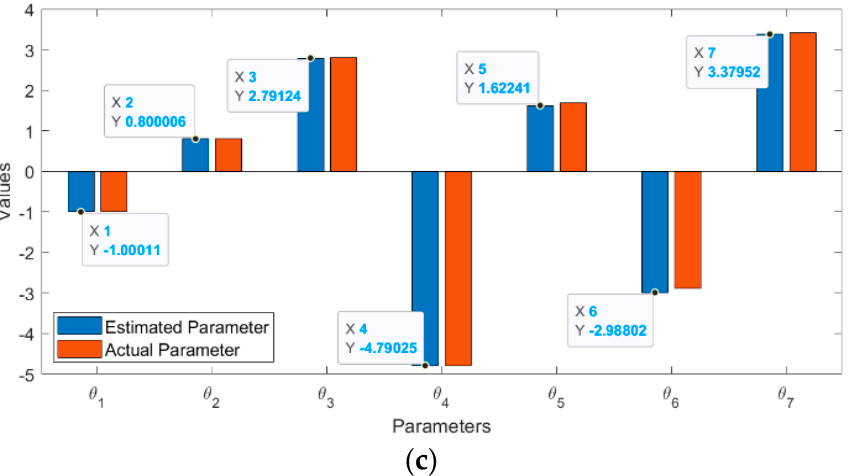
Figure 13. Results of estimated parameters in comparison with actual HC-AR parameters consid-